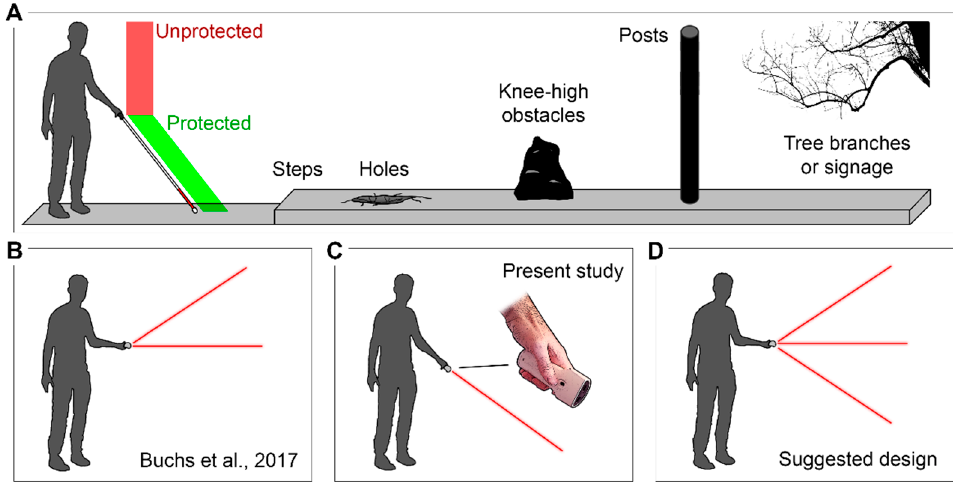
Figure 1. Schematics of ( A ) an individual with the white cane facing daily-life obstacles, the cane protects him from low obstacles; however, the individual is at risk of head injury with hanging obstacles like tree branches and signage; ( B ) an individual handling the EyeCane design used in [26]; ( C ) our experimental design with the single-sensor EyeCane in a downward directed manner and ( D ) an individual handling the three-sensors EyeCane design suggested in [26]. Table 1. Blind participants’